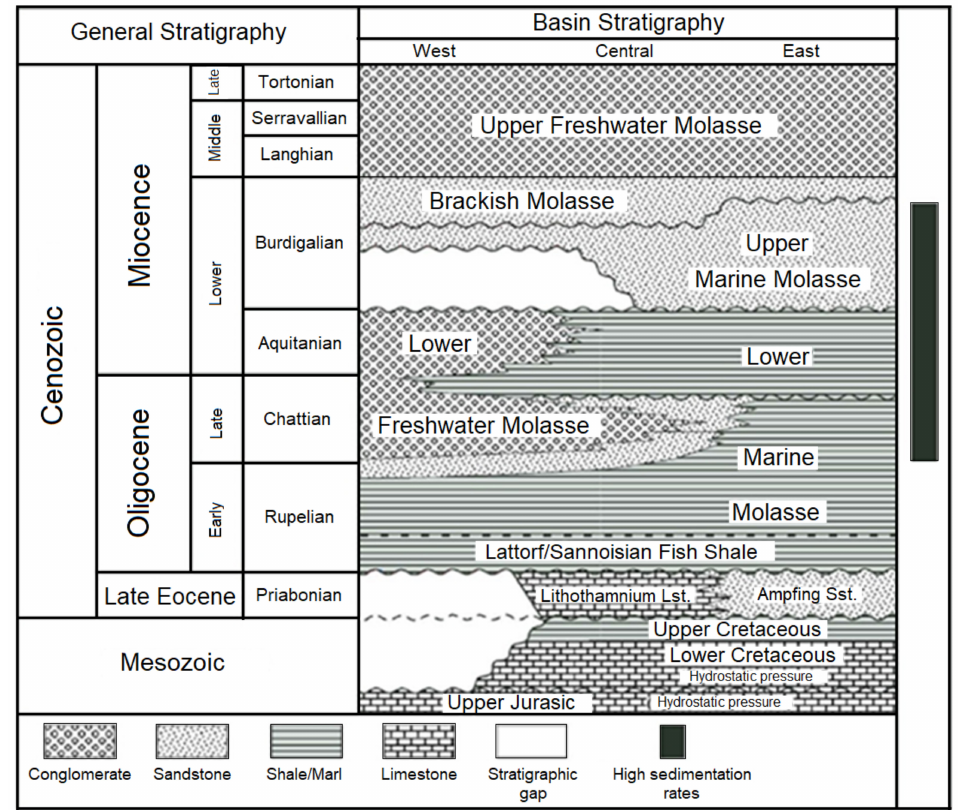
Figure 5. Stratigraphic overview of the Bavarian Molasse Basin along with the Mesozoic sub-Molasse succession [28]. High sedimentation rates correspond to distinct tectonic events in the Molasse Basin in Bavaria [10,30–32]. Reprint with permission [Michael et al.], 2018,